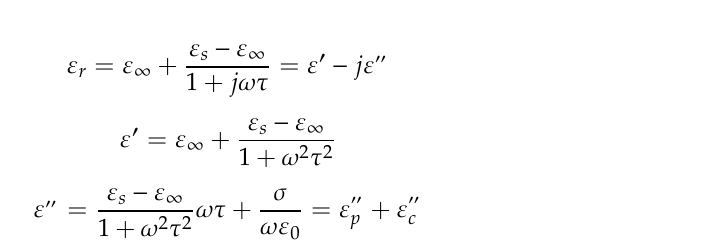
2 -1 composite ( a , b ), GNPs@Ni x S y @MoS 2